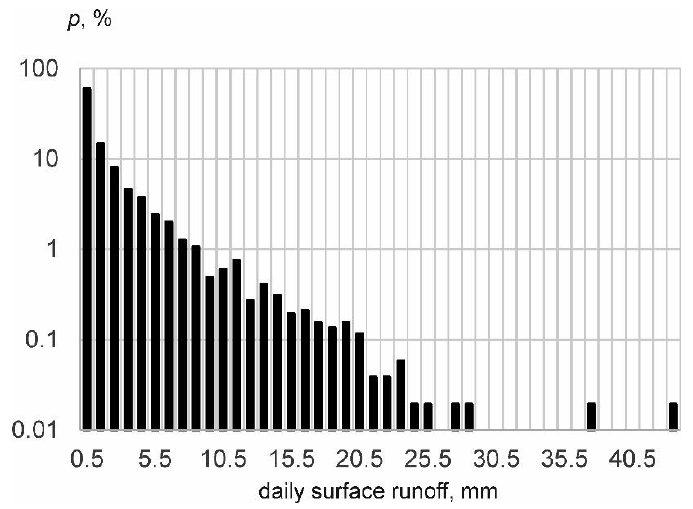
Figure 4. Histogram of daily surface runoff at the gully P-1 catchment.